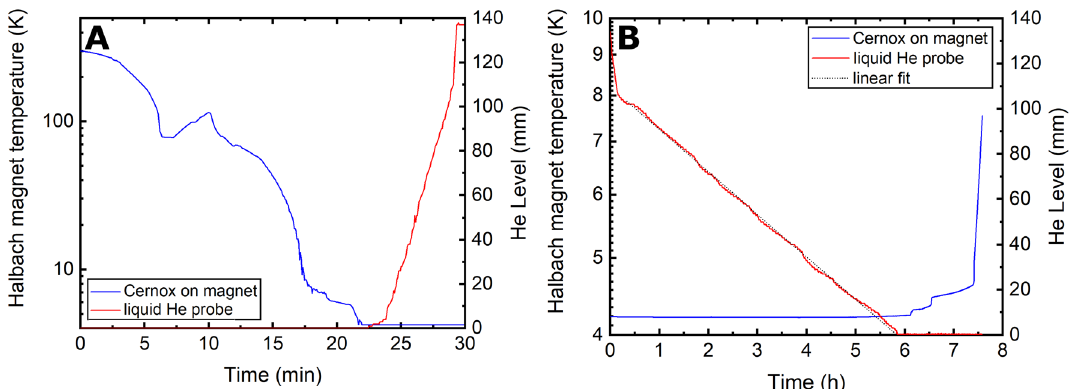
Figure 7. Cooldown and filling of the cryostat from room temperature to maximum liquid He capacity; the temperature of the magnet (blue line) and the He level (red line) were monitored ( A ). Holding time measurement after complete filling of the cryostat; the temperature of the magnet (blue line) and the He level (red line) were monitored; He consumption data were fit with a linear relation ( B